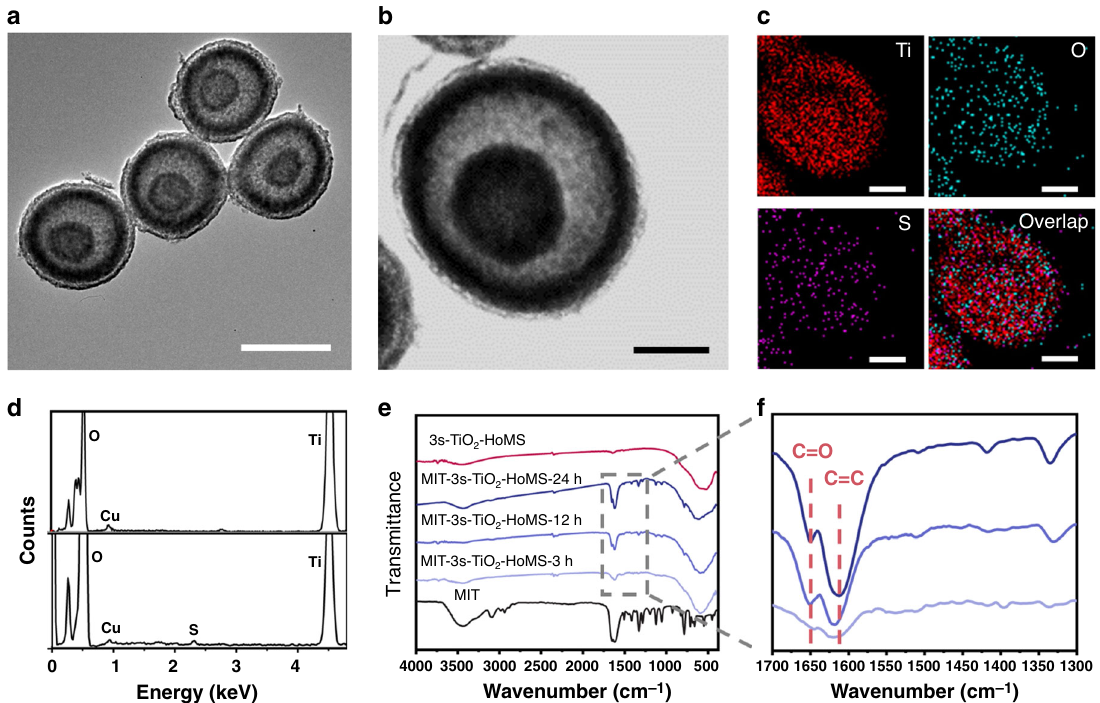
Fig. 2 Characterization of TiO 2 – HoMS before and after MIT loading. a TEM image of 3s-TiO 2 – HoMS. The scale bar is 500 nm. b STEM image of MIT-3s- TiO 2 – HoMS. The scale bar is 200 nm. c TEM-EDX mapping images of MIT-3s-TiO 2 – HoMS. The scale bar is 200 nm. d TEM-EDX spectra of 3s- TiO 2 – HoMS (top) and MIT-3s-TiO 2 – HoMS (bottom). e FTIR spectra of MIT, 3s-TiO 2 – HoMS and MIT-3s-TiO 2 – HoMS with different drug-loading period. f Enlarged FTIR spectra in the selected region. Source data are provided as a Source Data fi le.